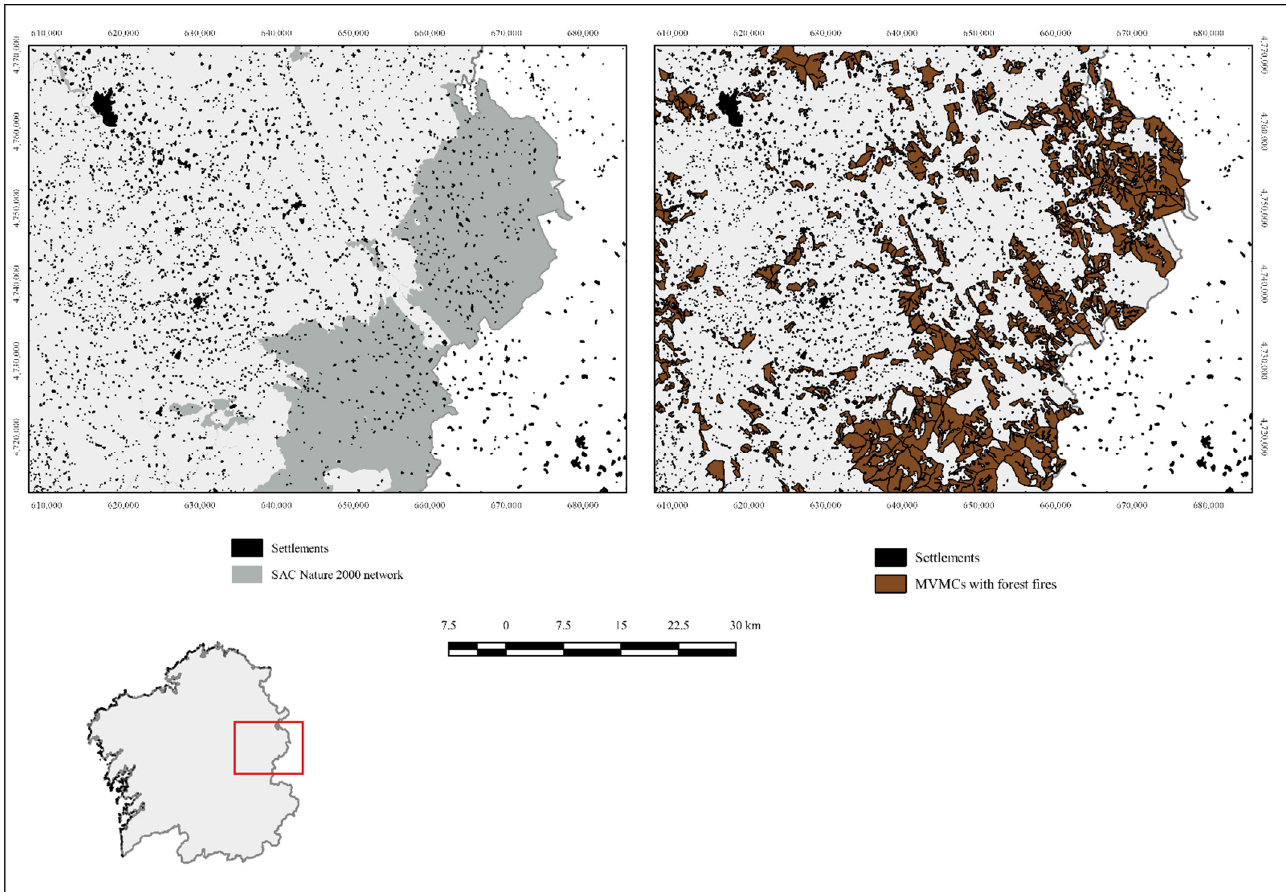
Figure 5. Official mapping of SACs and MVMCs (2021), showing the distribution of Galician MVMCs where human-induced forest fires occurred during the period under review compared to the distribution of SACs. Both layers intersect to create the territorial units MVMC-SAC and MVMC no SAC. The coordinate reference system used in the production of the maps was ETRS89/UTM Zone 29N.